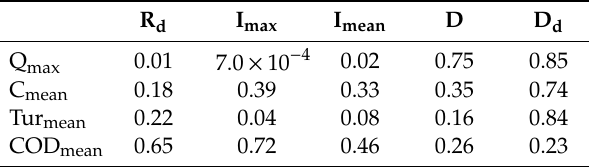
Table A3. Statistical significance ( p values) of the correlations between the variables of rainfall and CSO in the El Vado CSO.